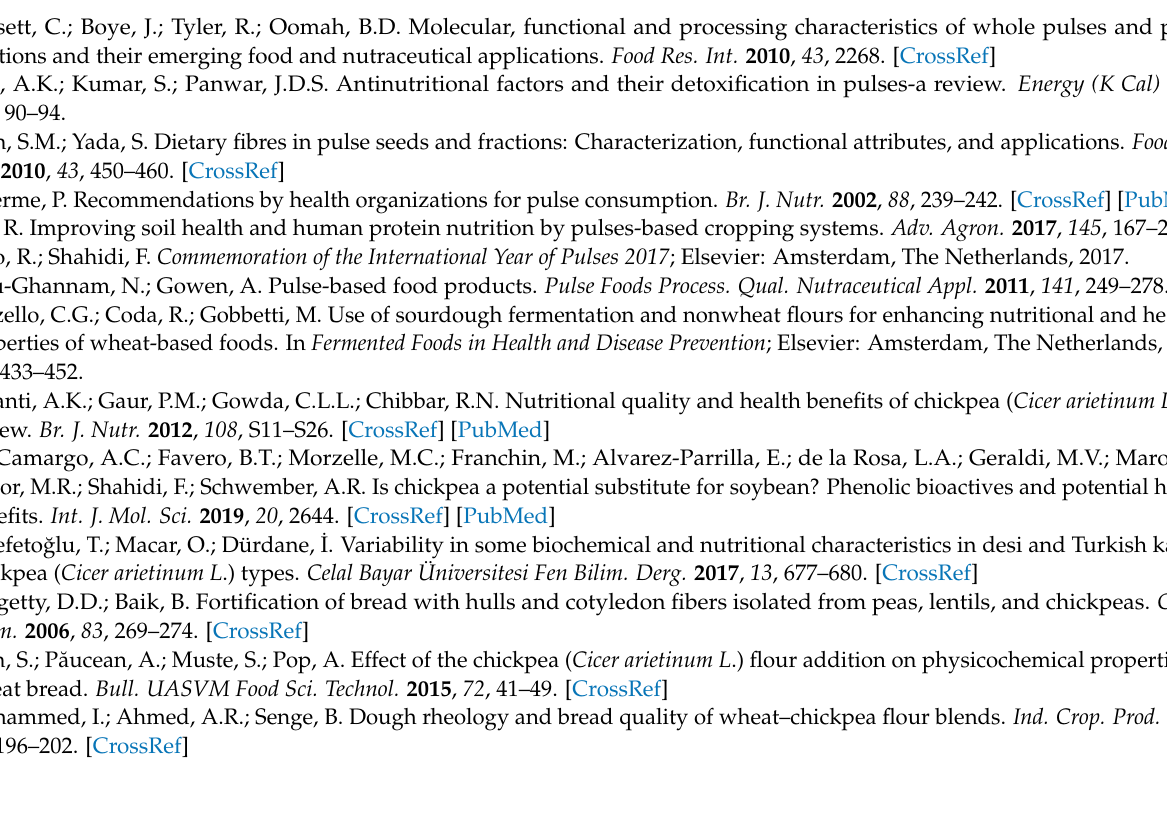
Figure S2: Average acceptance for optimized and control breads, Table S1: Graphical and numerical optimization of composite flour, Photo S1: Formulated breads: from left a)-optimized bread, b)-bread wheat bread